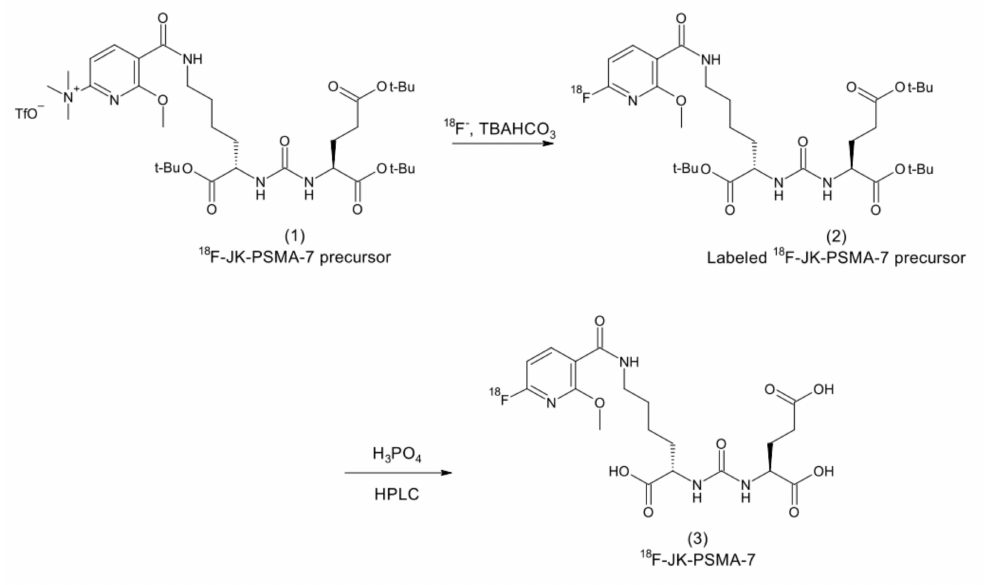
Figure 8. Scheme of the radiosynthesis of 18